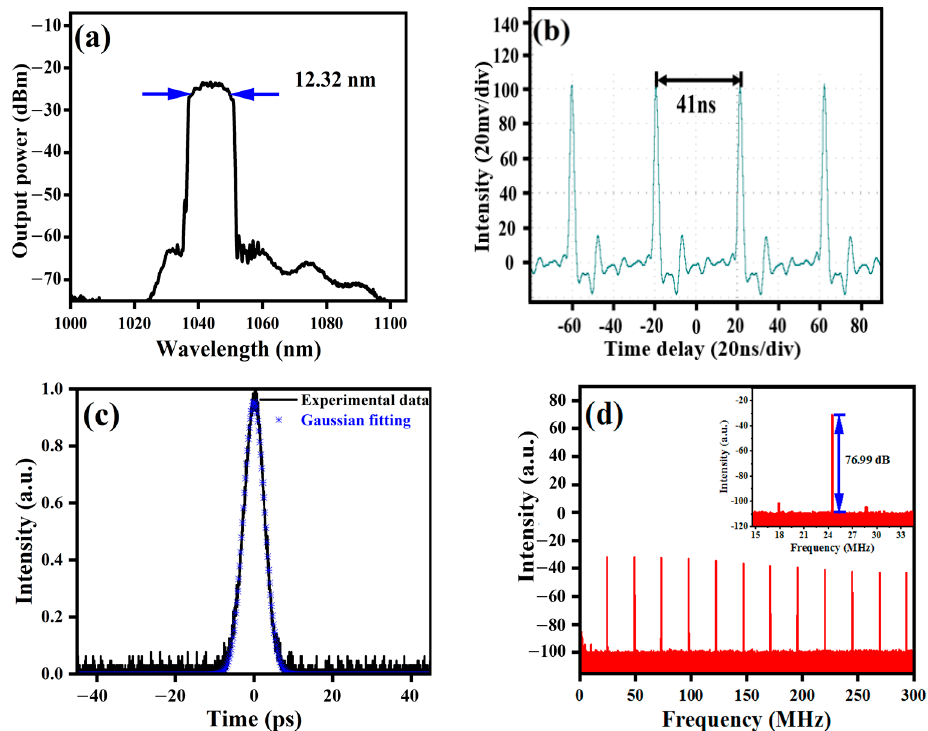
Figure 3. Output characeteristics with a filter bandwidth of 8.40 nm. ( a ) Output spectrum. ( b ) Pulse train. ( c ) Autocorrelation trace. ( d ) RF spectrum.